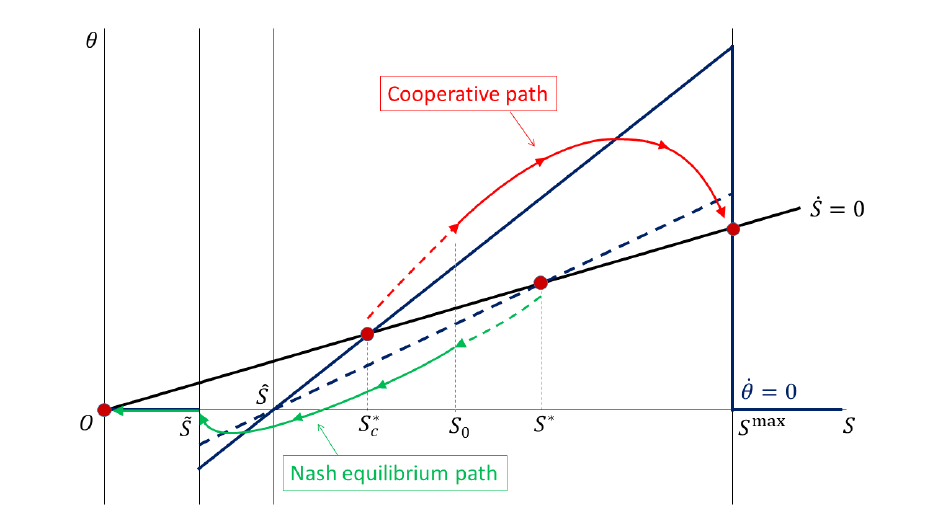
Figure 8. Comparison of steady states between noncooperative and cooperative